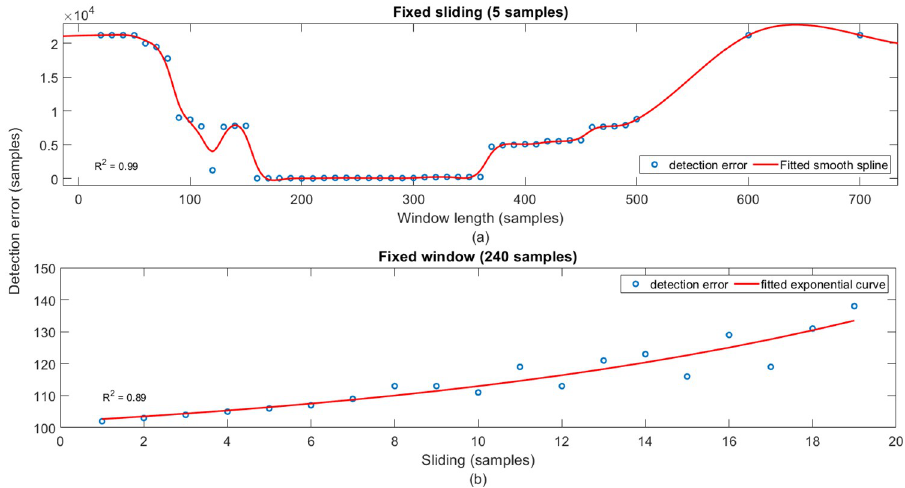
Fig 16. Sensitivity of crucial parameters. Effects of (a) varying window length for a fixed sliding length of 5 samples and (b) varying sliding length for fixed window length of 240 samples on the performance of the proposed method. Vertical axis indicates the detection error for varying tuning parameters. Blue color circles indicate the detection error, and the red color solid line is the fitted curve for both the parameters.